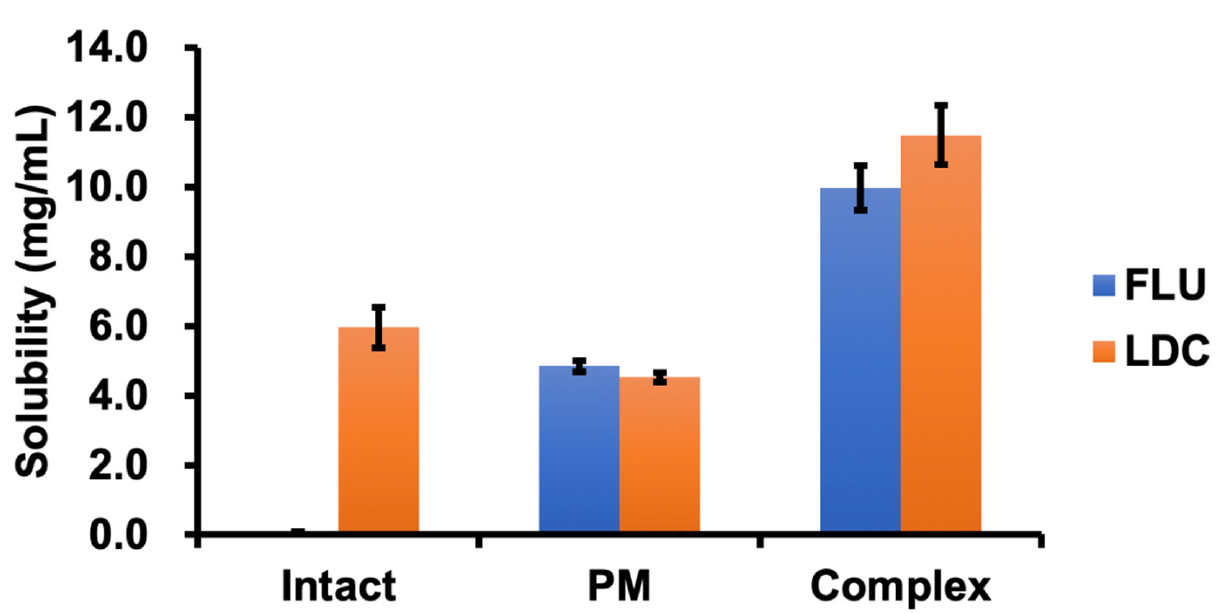
Figure 6. Solubility of FLU and LDC from the Complex at 32 °C ( n = 3, the bar indicates the average ± S.D.).